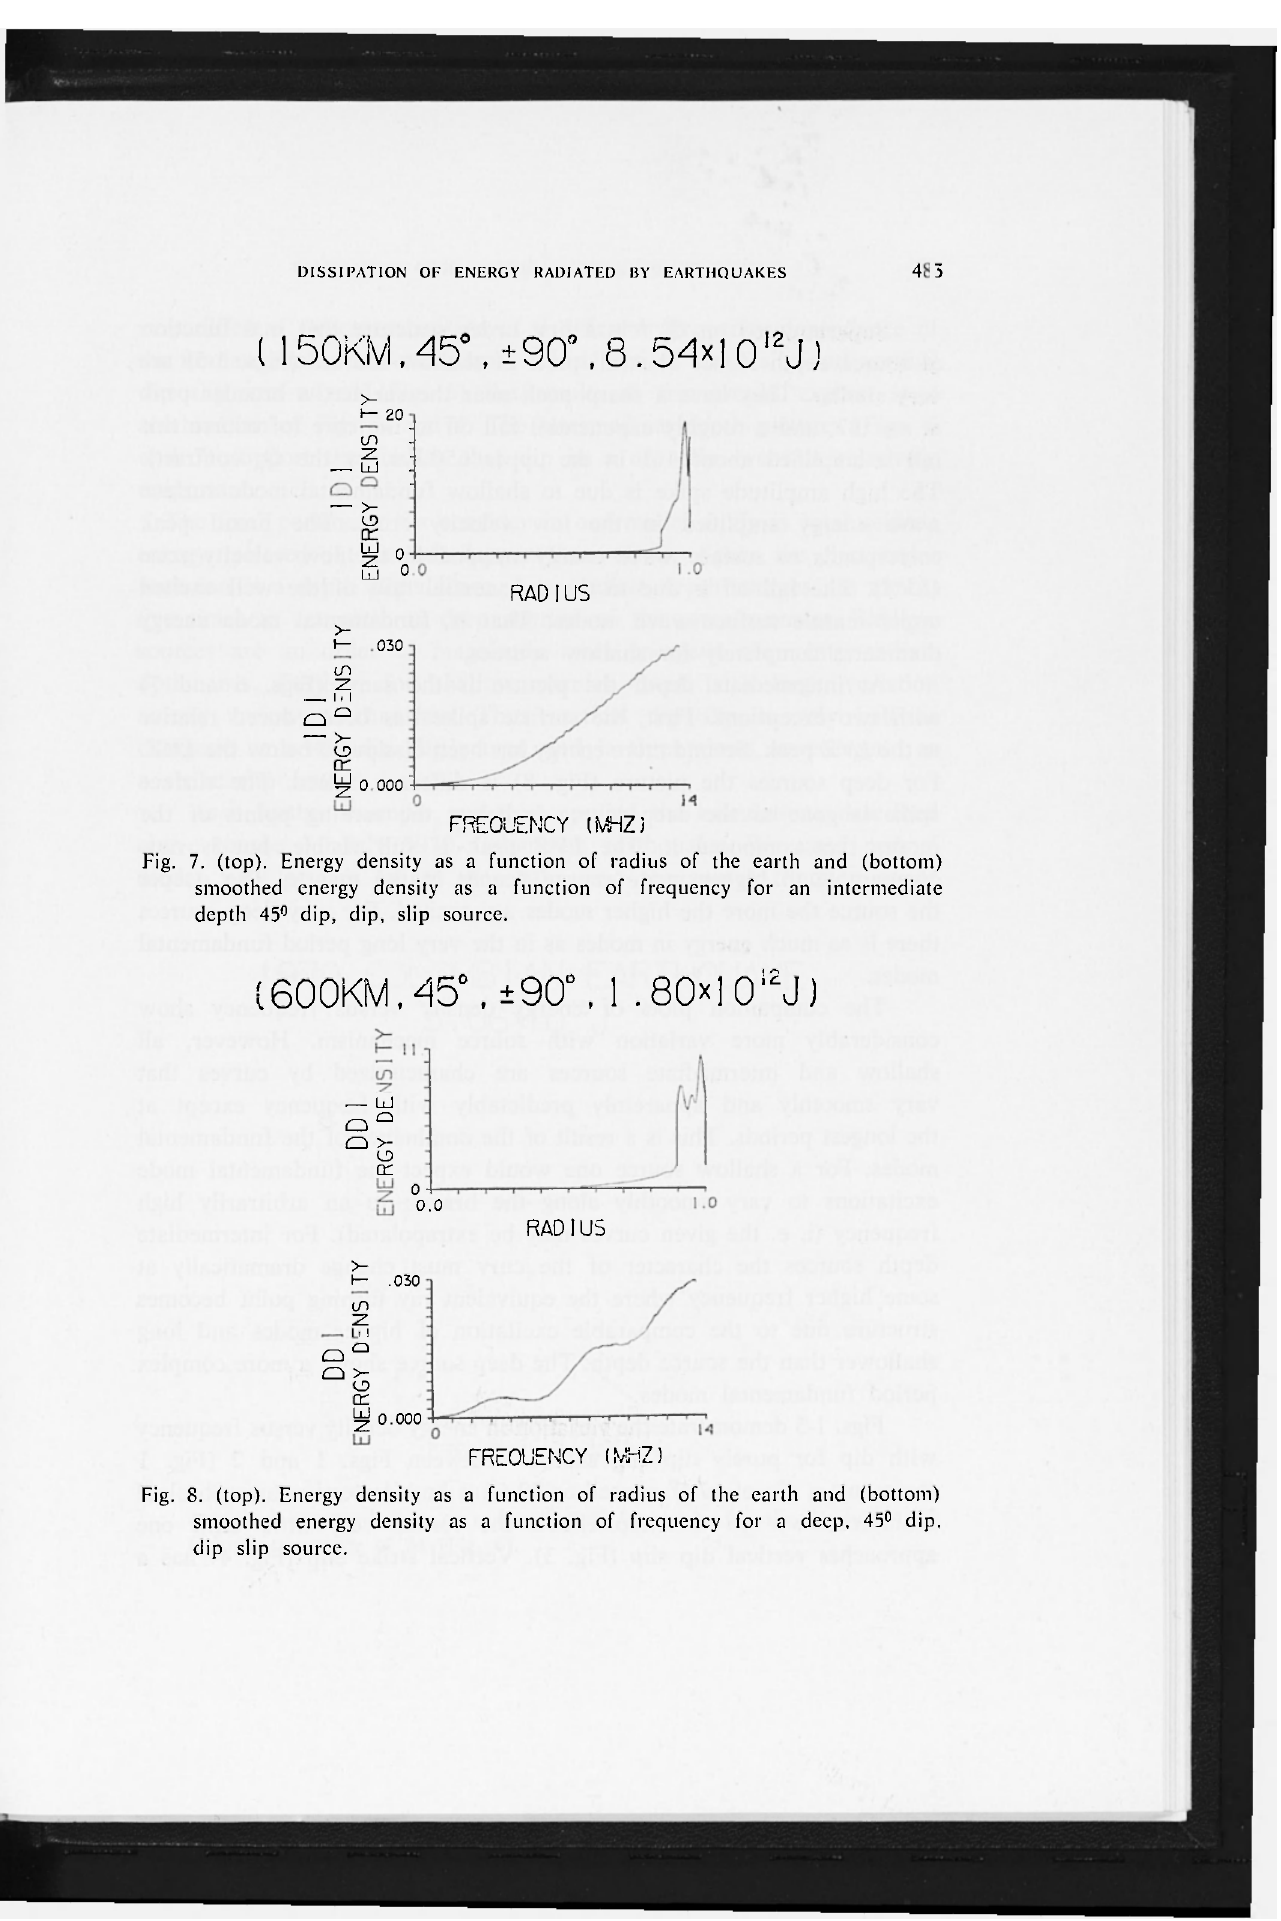
Fig. 8. (top). Energy density as a function of radius of the earth and (bottom) smoothed energy density as a function of frequency for a deep. 45° dip, dip slip